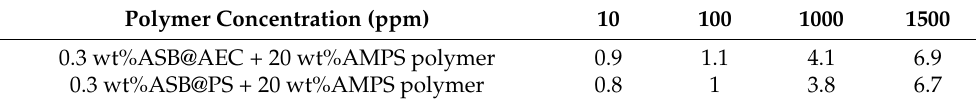
Table 3. The viscosity (cP) of surfactant–polymer solutions (80 ◦